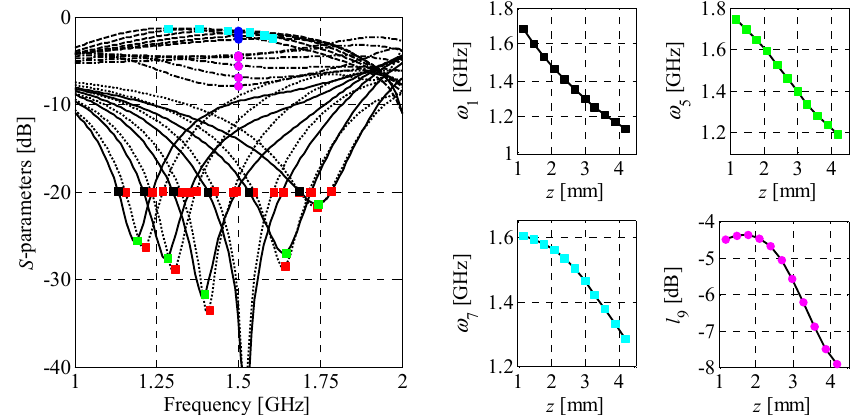
Figure 8. Family of BLC characteristics (left-hand side) obtained for an arbitrarily selected line segment z in the search space and their corresponding feature-based responses (right-hand side) defined w.r.t. level (squares) and frequency (circles). Marker colors on frequency plot correspond to marker colors on the selected feature plots.